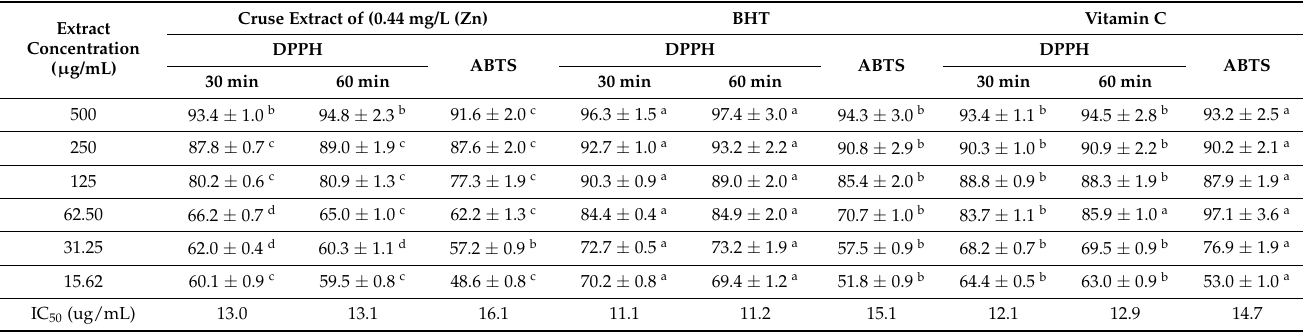
Table 9. Antioxidant activity (as % and IC 50 ) of the effective extracts (0.44 mg/L (Zn) of Nostoc linckia compared with BHT and vitamin C as standards (using DPPH and ABTS radical